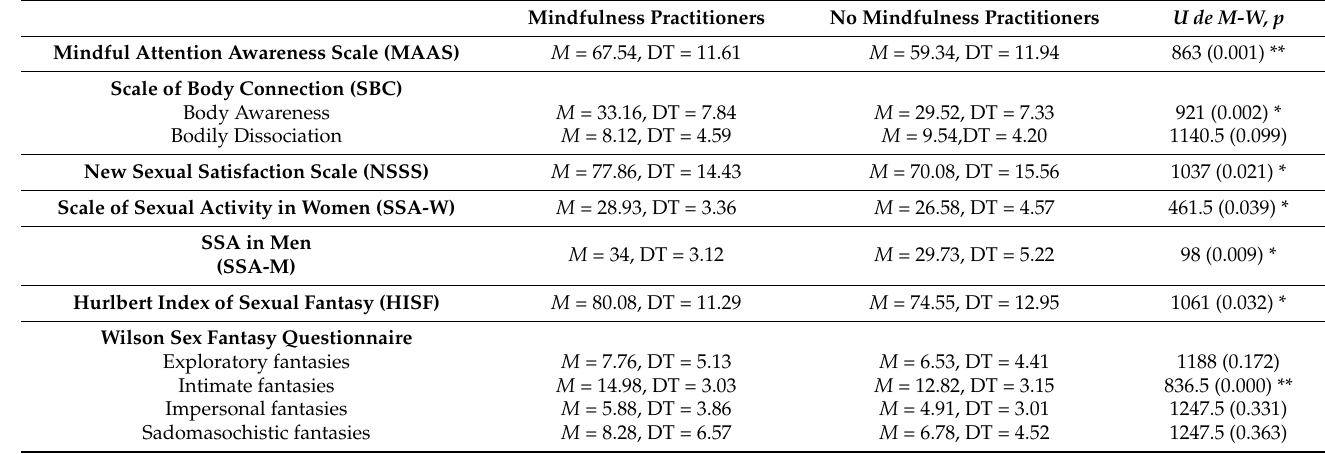
Table 2. Mann-Whitney U test, means and standard deviations of applied measures, comparisons between Mindfulness practitioners and non-practitioners.